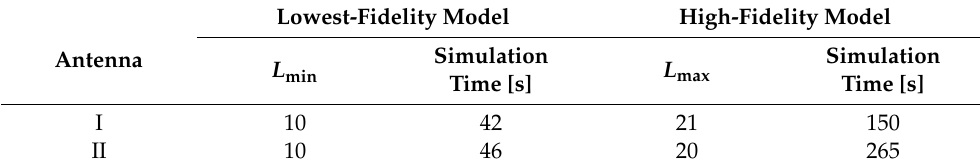
Table 2. Benchmark Monopole Antennas: Discretization Density Ranges and Simulation Times.